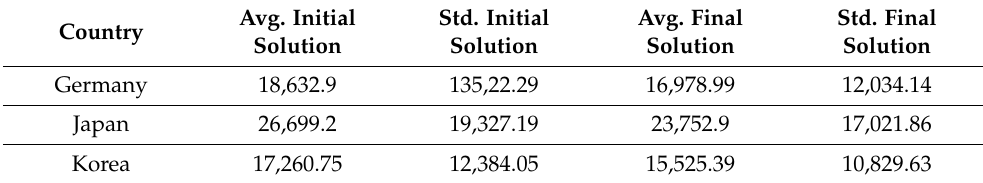
Table A5. Comparison of three countries’